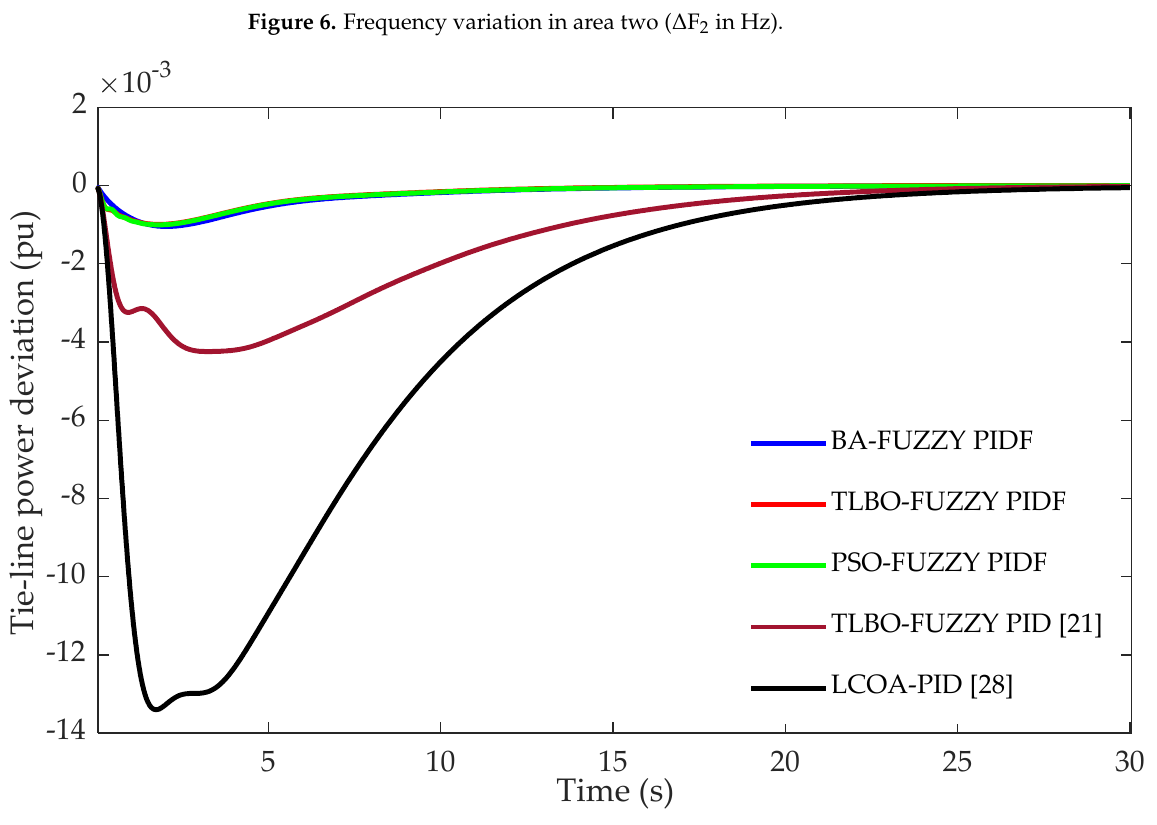
Figure 7. Tie-line power variation ( ∆ P tie in pu).